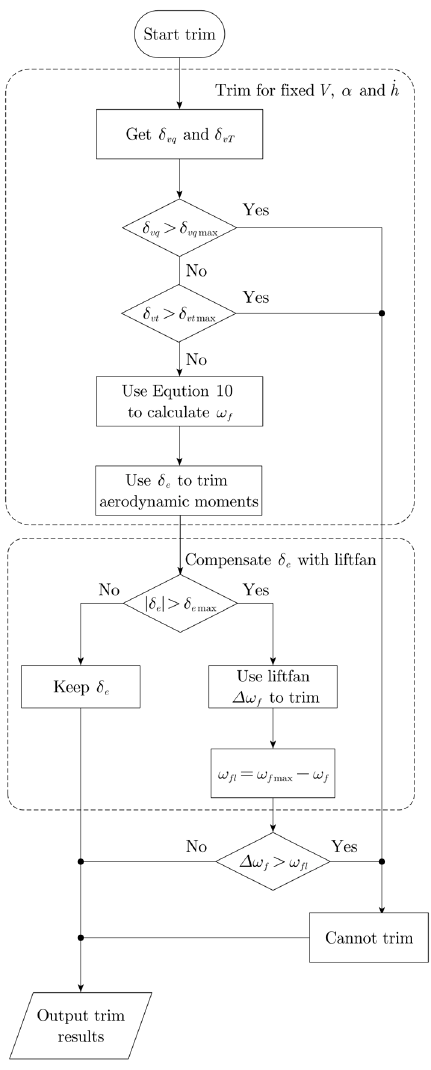
Figure 8. Trim procedure for short-landing performance analysis.